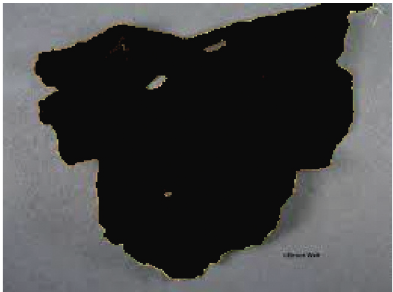
Figure 9: Objects in cluster 1.